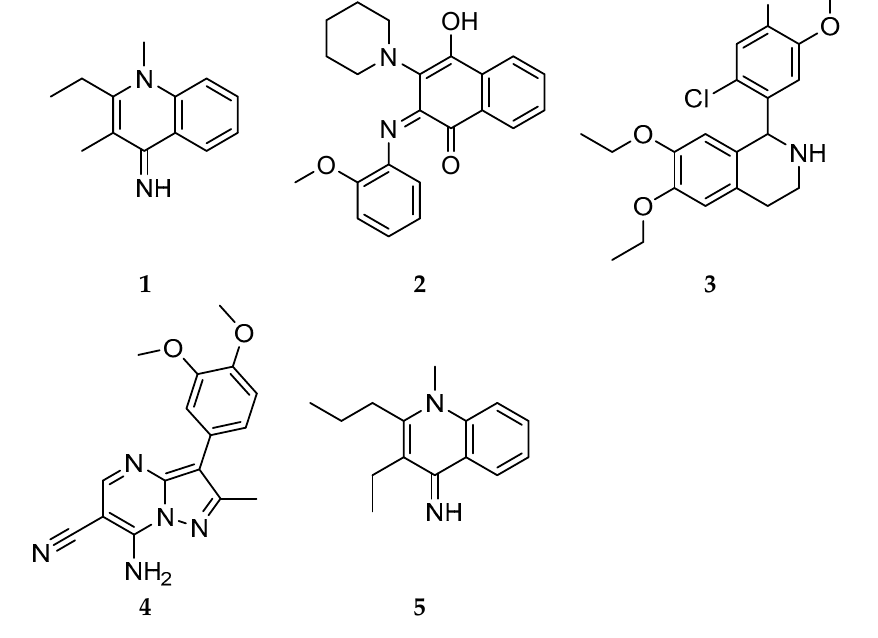
Figure 1. Structures of Pf TrxR inhibitors ( 1 – 5 ). Table 1. Identification of the five active Pf TrxR inhibitors.